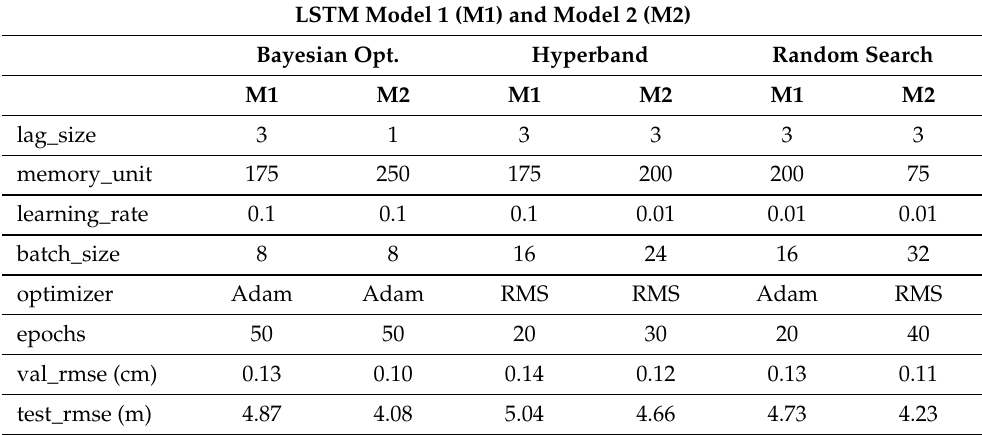
Table 3. LSTM Model 1 and Model 2 first stage HPO results. LSTM Model 1 (M1) and Model 2 (M2) Bayesian Opt.